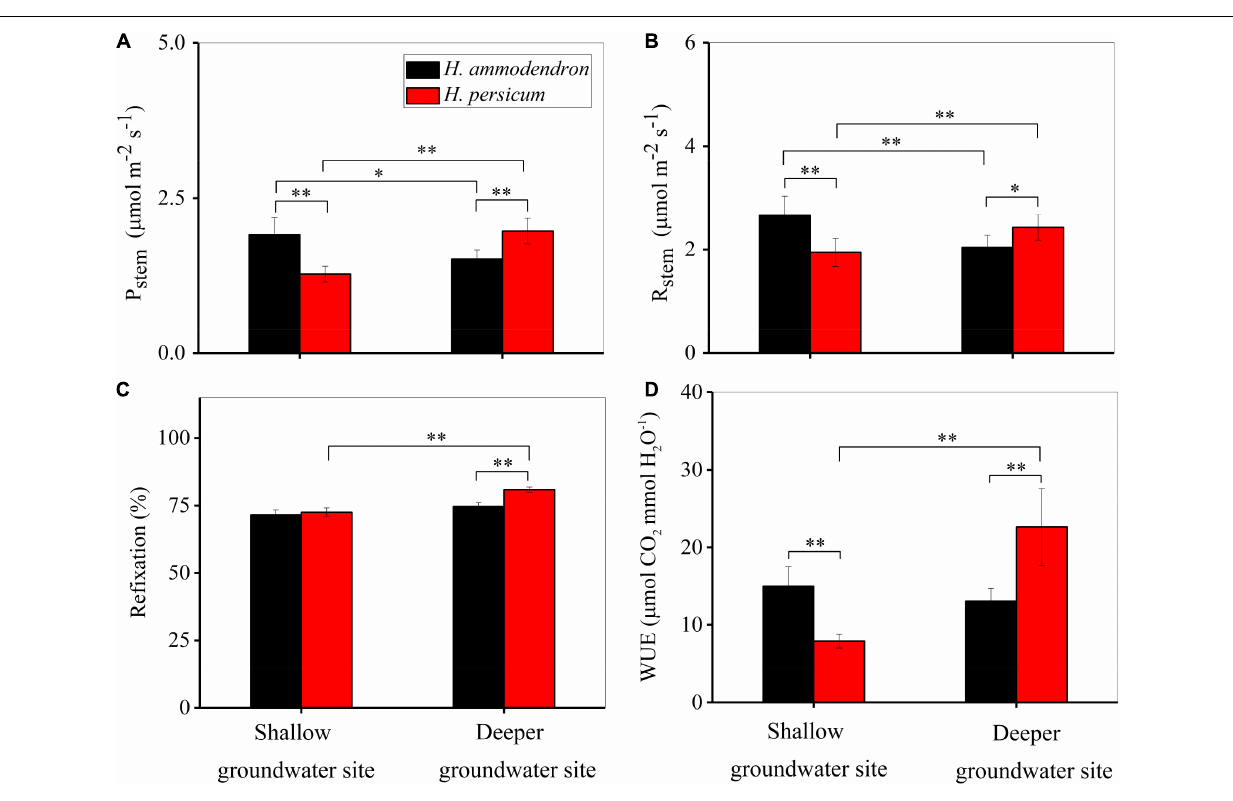
FIGURE 6 | Comparison of daily average stem ( P stem ) photosynthesis (A) , stem dark respiration ( R stem ) (B) , stem refixation (C) (expressed as a percentage of P stem and R stem ), and stem water use efficiency (D) for two Haloxylon species at two sites. Error bars represent SE ( n = 18). * P < 0.1, ** P <